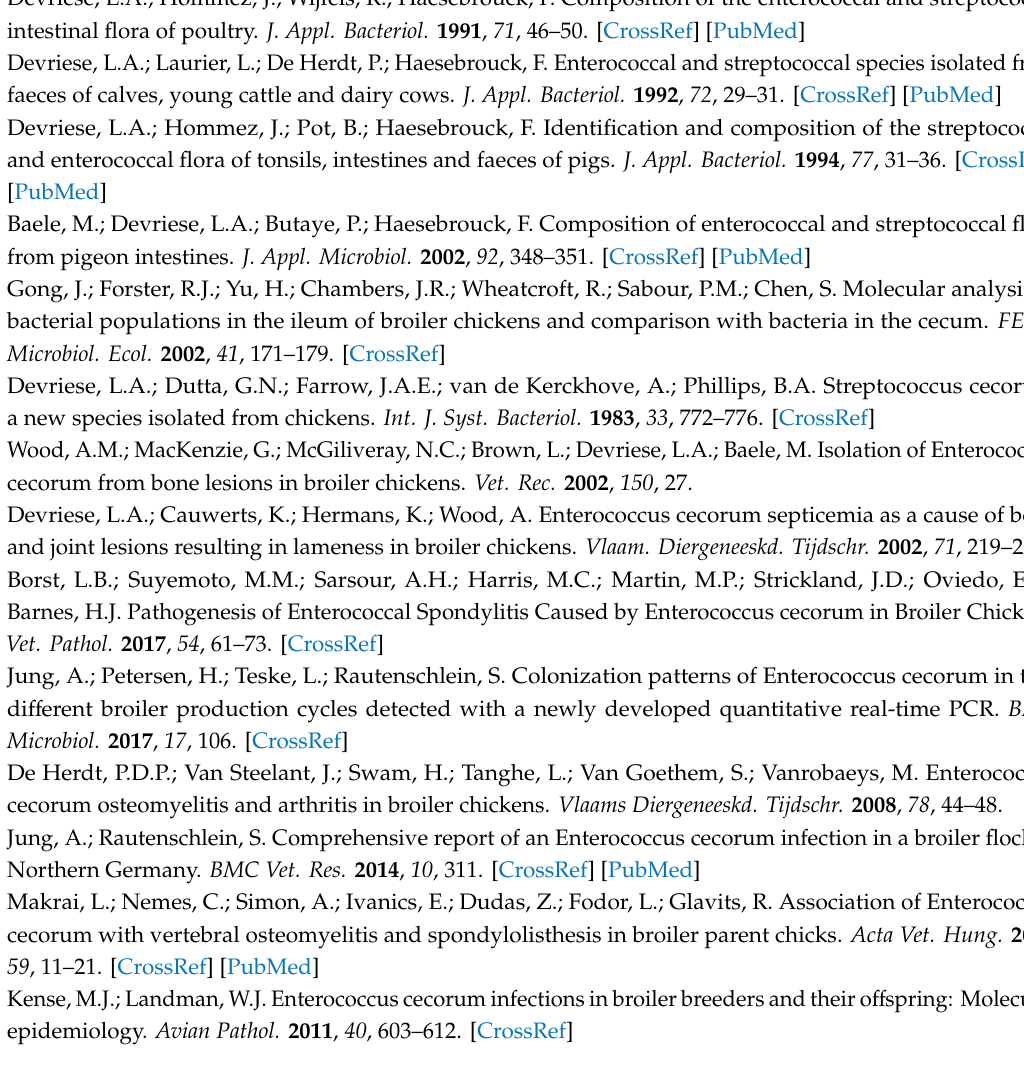
Table S1: List of online tools used in this study; Table S2: Clusters of Orthologous Groups (COG) in the clinical and non-clinical Enterococcus cecorum isolates; Table S3: Genome assembly statistics and metadata of clinical and non-clinical Enterococcus cecorum ; Table S4: List of core gene predominantly present in Enterococcus cecorum isolates from healthy and diseased chickens; Table S5: List of Enterococcus cecorum genomes used for phylogenetic